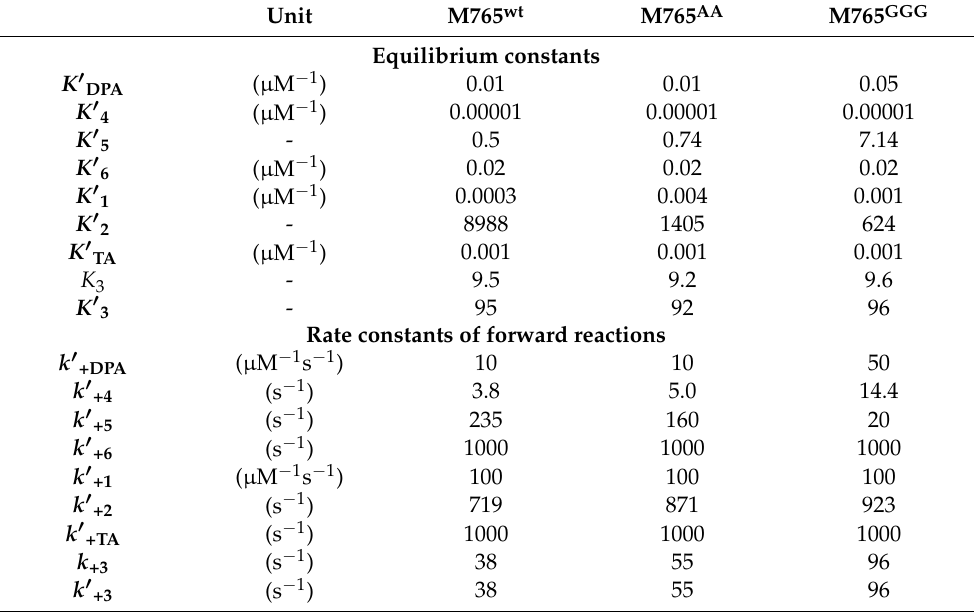
Table 5. Parameters used for the estimation of the fractional occupancies of intermediate